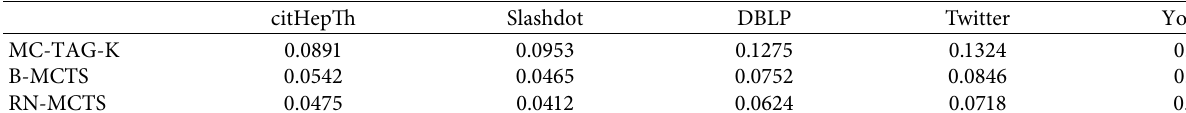
Figure 3: The average ranking function value based on different iterations. Table 3: The difference between approximate and true ranking function values.